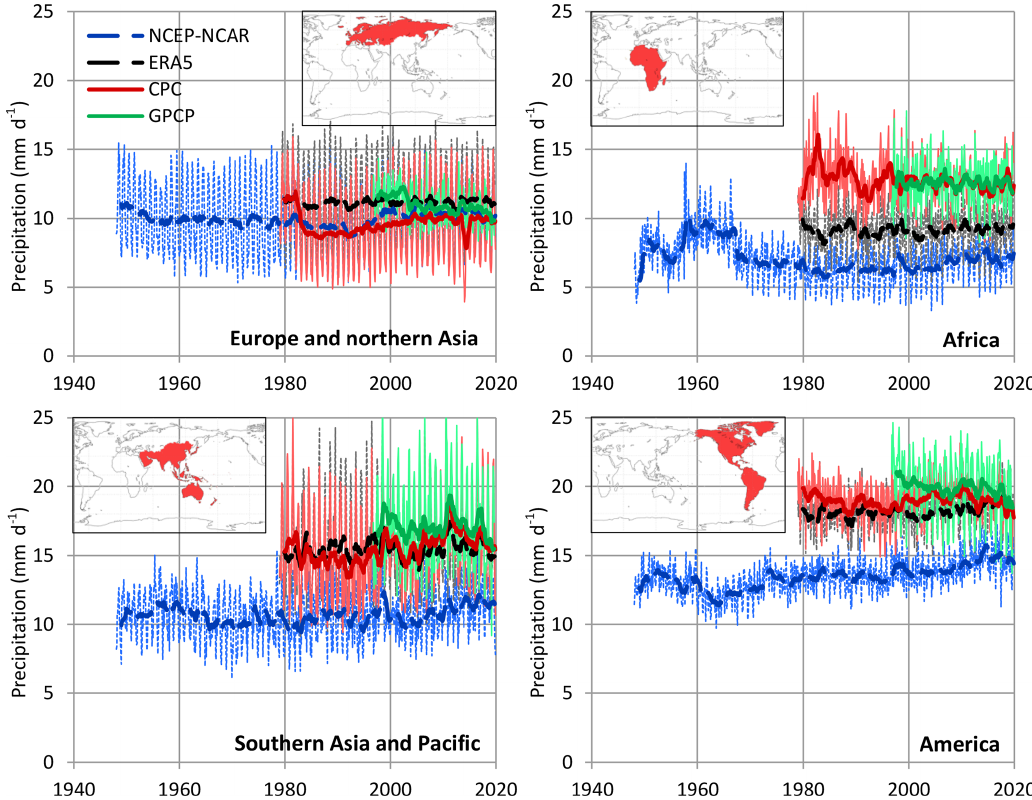
Figure B1. Variation of the monthly maximum daily precipitation areally averaged over the continents. Thin and thick lines of the same colour represent monthly values and running annual averages (right aligned), respectively. Dashed lines are for reanalyses and continuous lines for observations. Sources of the data are indicated in the legend and detailed in Table